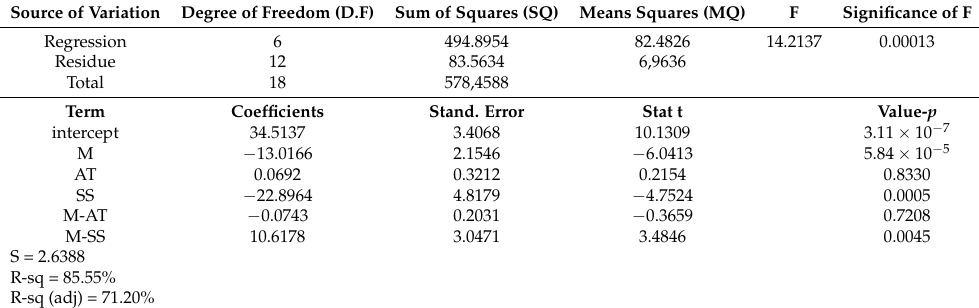
Table 7. ANOVA of factorial design for Izod Impact Resistance